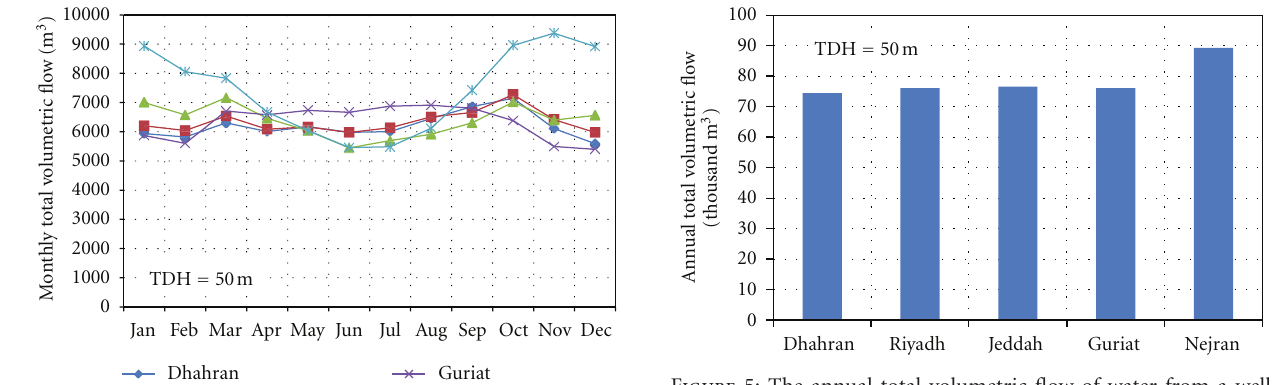
Figure 5: The annual total volumetric flow of water from a well with total dynamic head of 50m using solar PV-operated Goulds model 45J series pump for five di ff erent sites in Saudi Arabia.